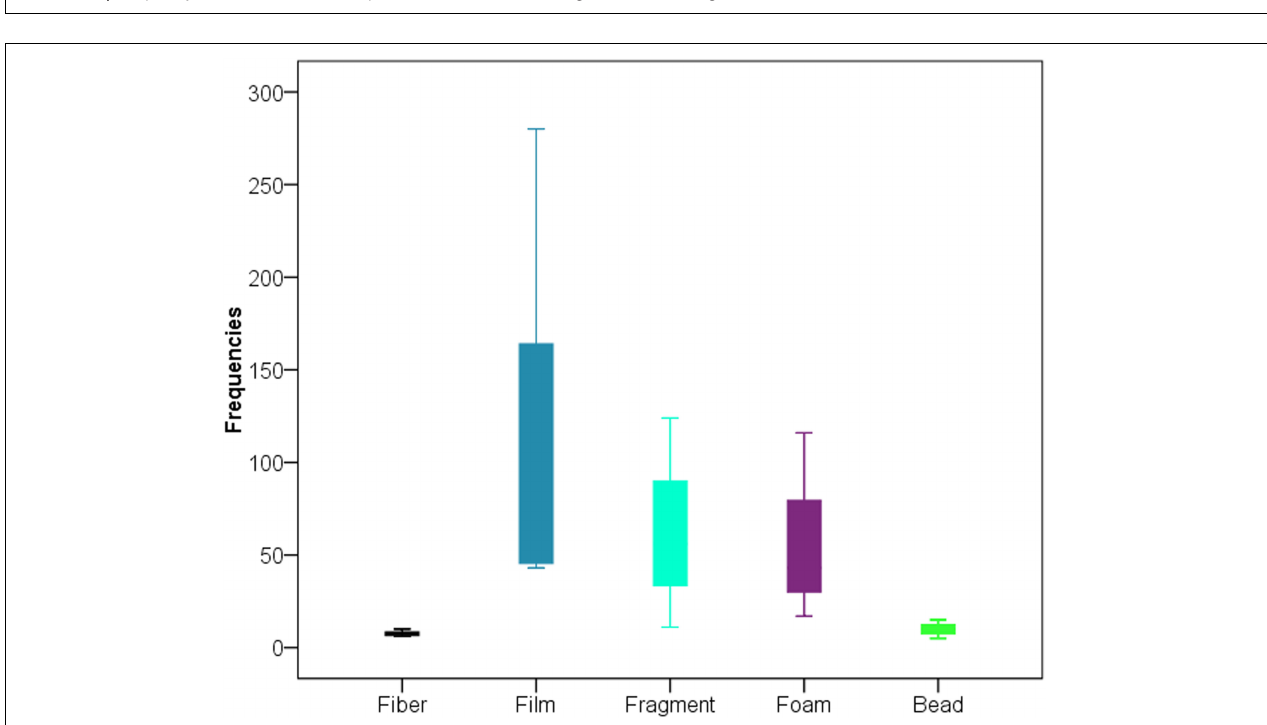
FIGURE 2 | Frequency of occurrence of microplastic detected from three gastrointestinal organs.